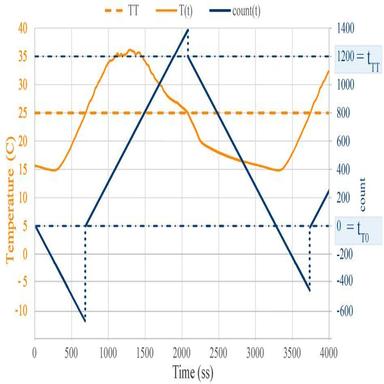
Example of the count(t) function trend in response to a temperature profile for a surface with TT = ° 25 C.